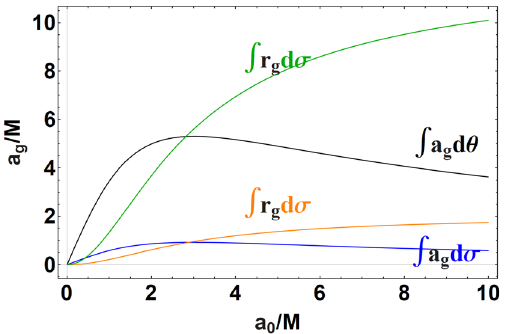
Fig. 30 Areas of regions bounded by special curves. Based on the analysis of Eq.